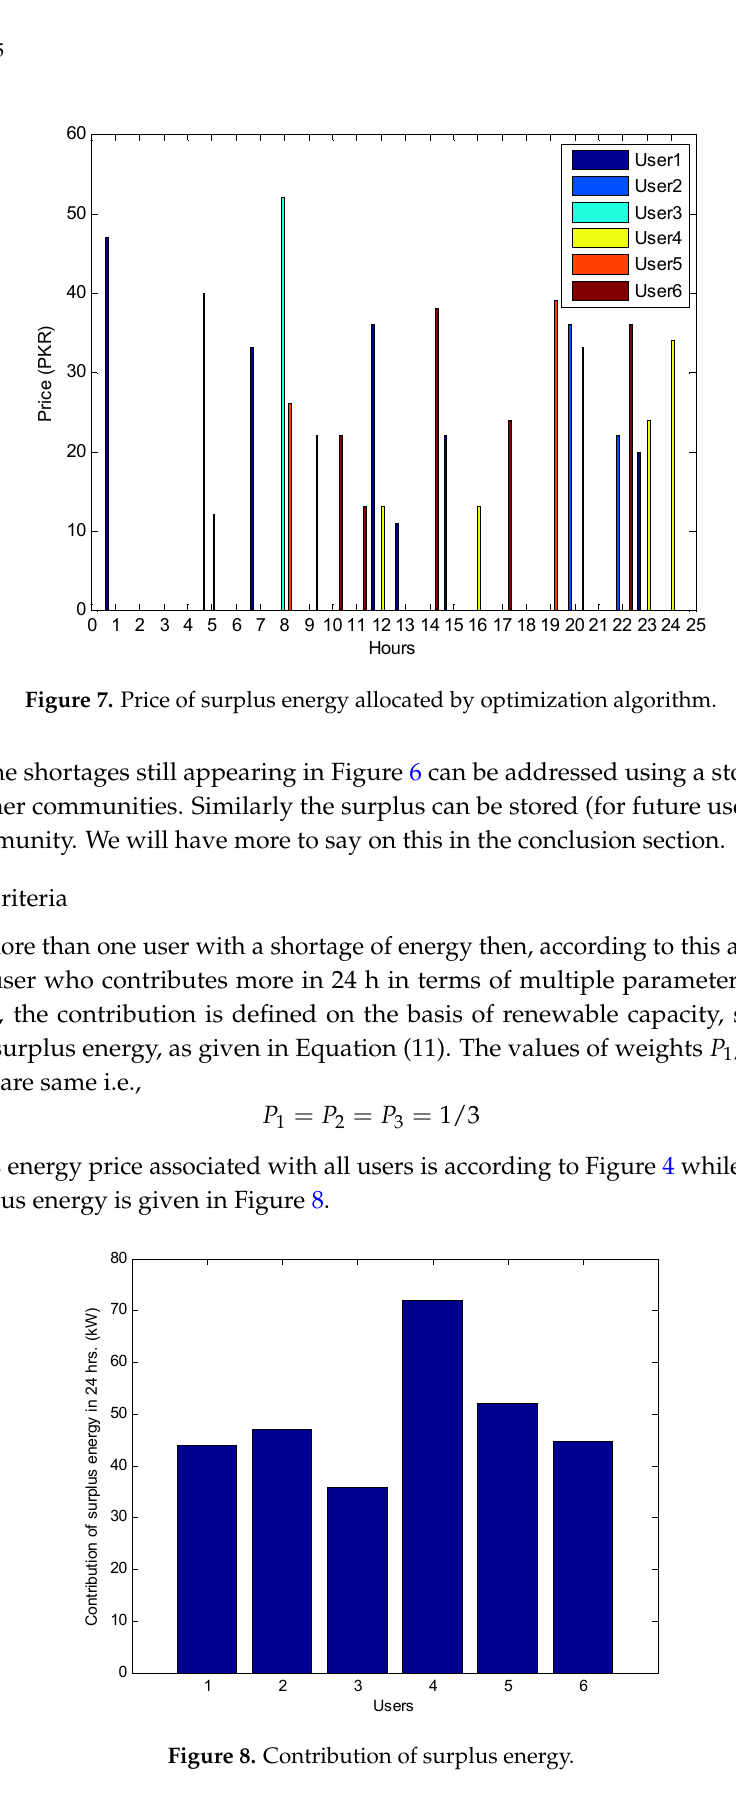
Figure 6. Shortage and surplus energy after the optimization.